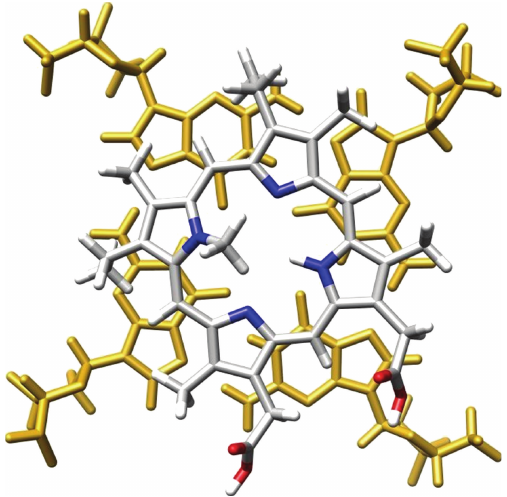
Figure 12: Qualitative in silico superposition of NMM and a G- tetrad (extracted from PDB entry: 2A5R); guanine residues appear in gold; the carbon, nitrogen, oxygen, and hydrogen atoms of NMM in grey, blue, red, and white,